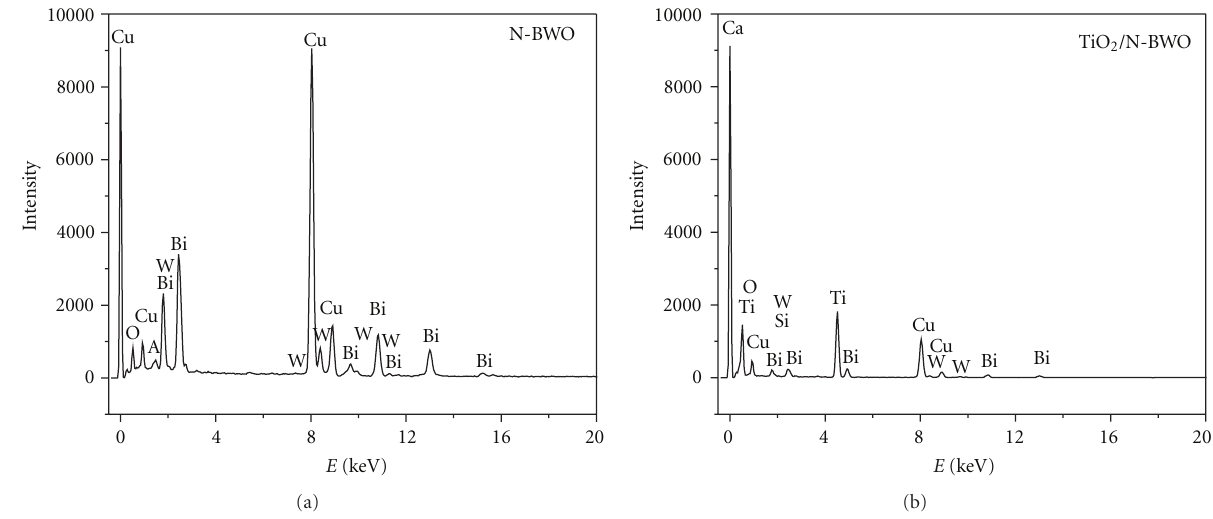
Figure 4: Energy dispersive spectra for the as-prepared N-BWO and TiO 2 /N-BWO.